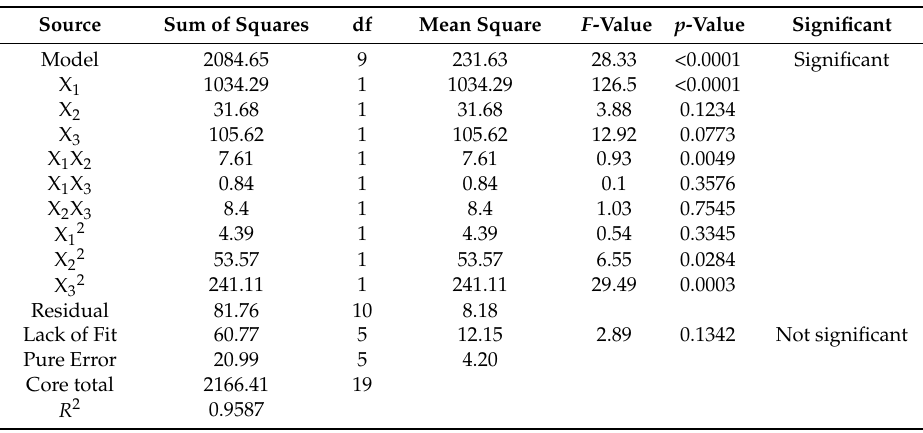
Table 2. Analysis of variance for the quadratic polynomial model.